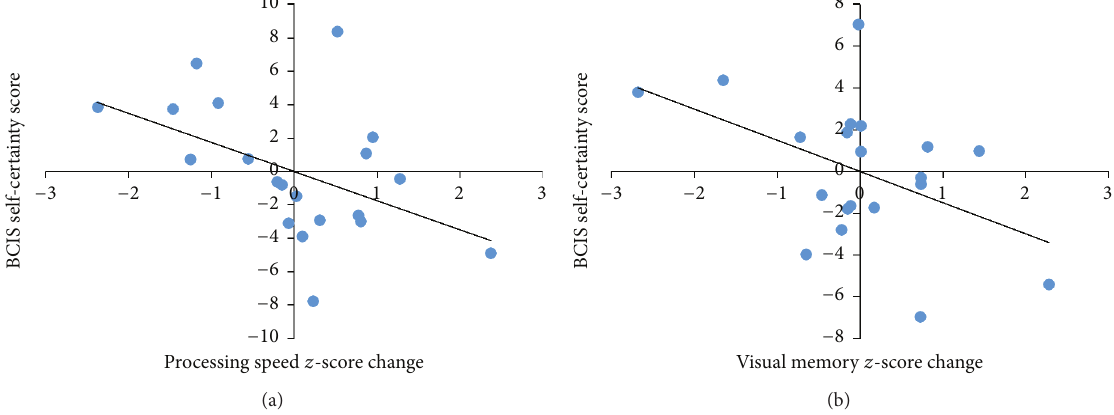
Figure 1: Partial correlations between baseline insight levels and improvement in cognition after CRT. Note: (a) baseline BCIS self-certainty score and improvement in speed of processing; (b) baseline BCIS self-certainty score and improvement in visual memory.